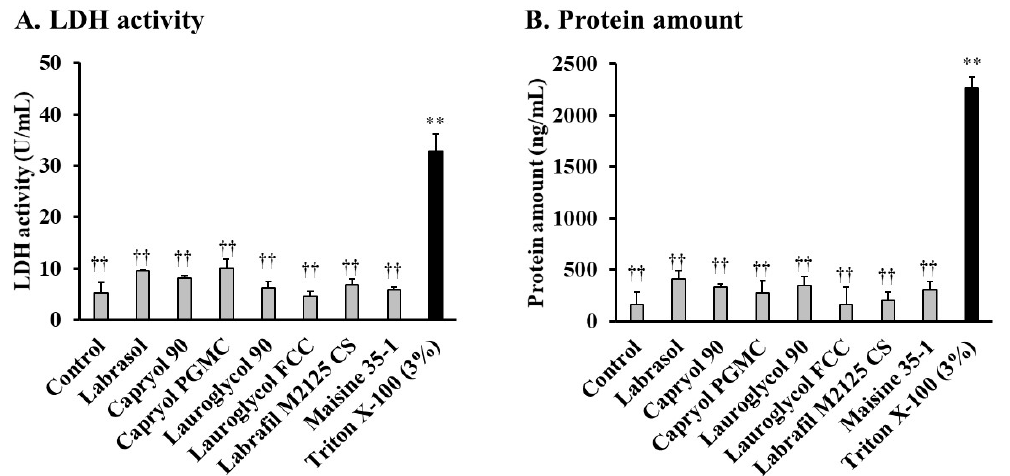
Figure 2. Effects of 10% ( v / v ) Labrasol ® and its related formulations on the ( A ) lactate dehydrogenase (LDH) activity and ( B ) amount of protein released from rat small intestinal mucosa by an in situ closed-loop study. Each value represents the mean ± S.E. of at least three experiments. (**) p < 0.01, compared with the control group. (††) p < 0.01, compared with the positive control group.